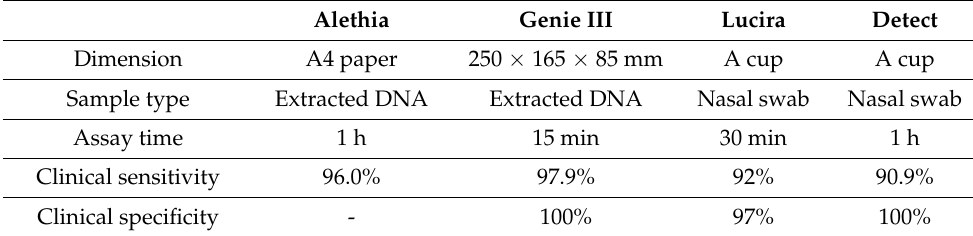
Table 2. Specifications of commercial LAMP devices. Data retrieved from [97–104].